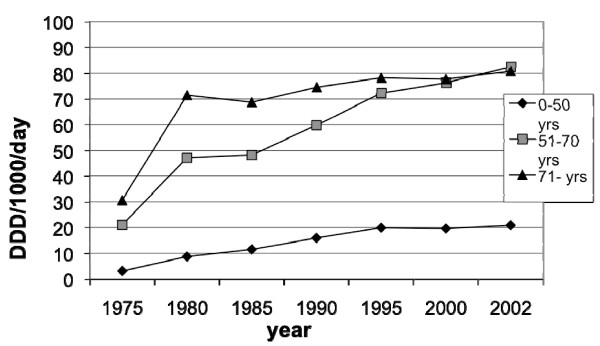
Sales of prescribed NSAID and ASA between 1975–2002 in Sweden among females.